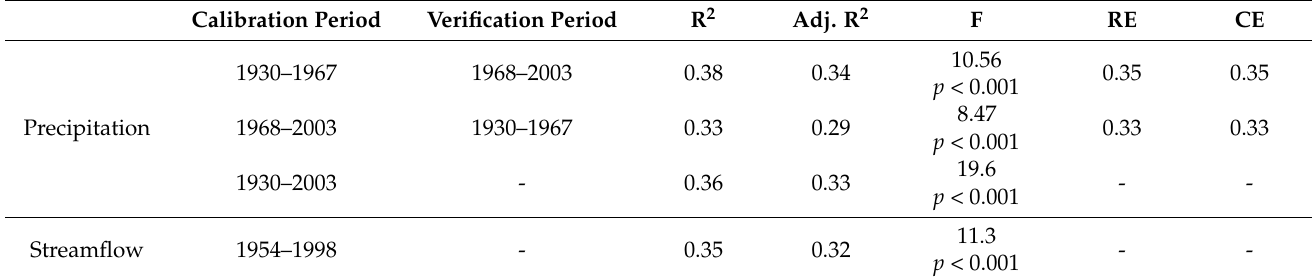
Table 4. Calibration and verification statistics of P April–July and S April–August reconstructions.